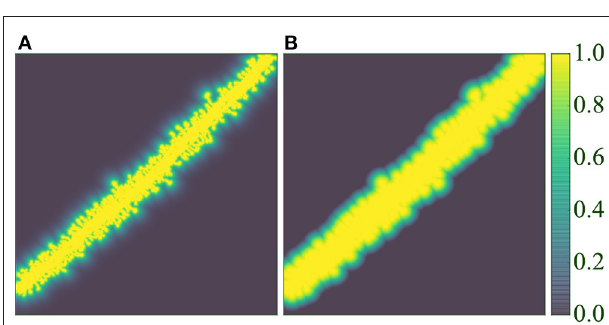
FIGURE 7 | Distance weight maps: (A) uses (5) with r decay = 0.5, and (B) uses (6) with d max = 5 µ